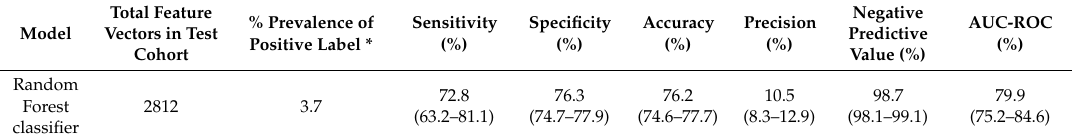
Table 2. Predictive performance of the ICU prediction model in the test set.